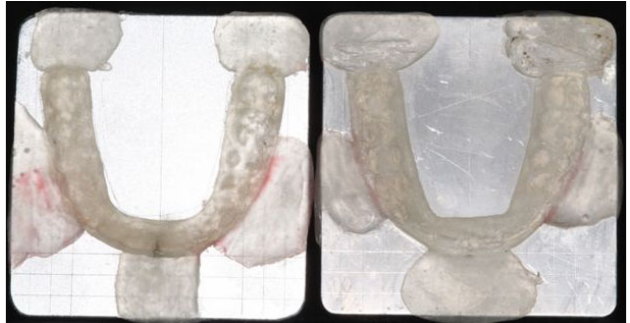
Fig. 1. Superior view of the splints with a flat inferior surface adapted with acrylic resin on the superior surface of the seven and thirteen degrees planes.